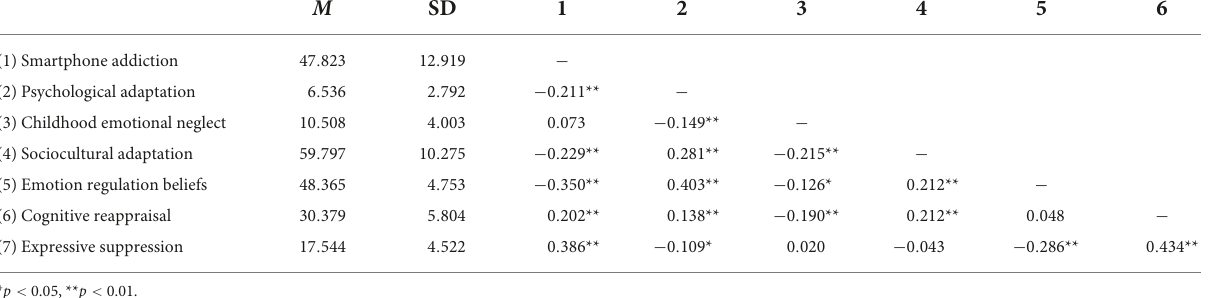
TABLE 2 Mean, standard deviation and bivariate correlation between measured variables ( n = 356). M SD 1